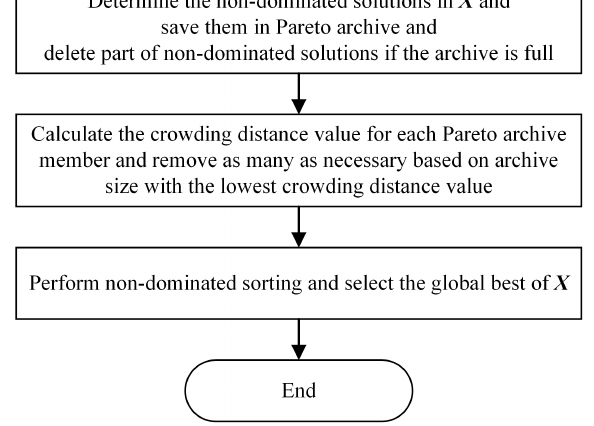
Figure 2. Flowchart of the required operations of